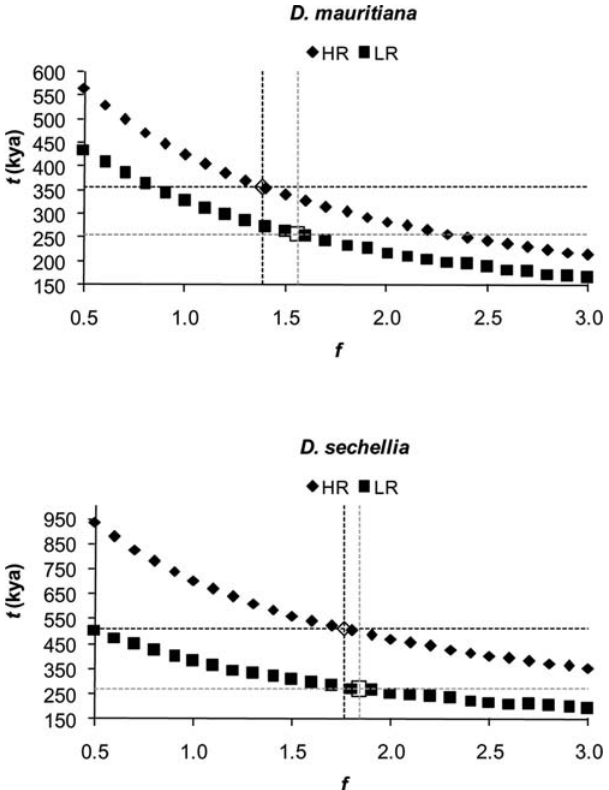
Figure 3. Sensitivity of isolation time estimates to substitution rate along the island species lineage. Open markers (intersected by dashed horizontal and vertical lines) indicate estimates of t corresponding to f under the 2-parameter model. All other points indicate values of t corresponding to arbitrary values of f ranging from 0.5 to 3.0. HR, high-recombination loci; LR, low-recombination loci.